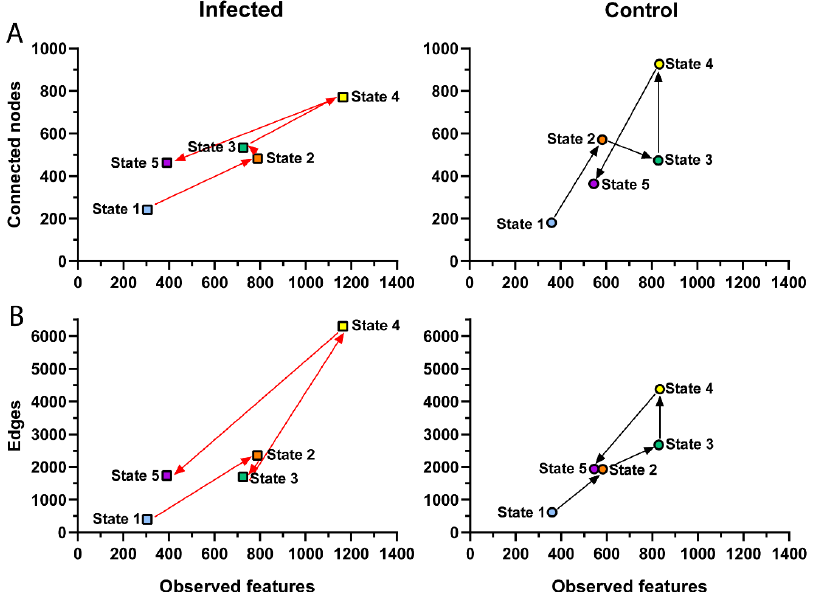
Figure 5. Changes in microbiome structural states of P. homocircumflexum -infected and control groups. Scatter plot showing the mean of observed features versus number of ( A ) connected nodes and ( B ) edges found in the microbial co-occurrence networks of infected (left) and control (right) birds throughout the course of experiment, from state 1 (8 DPI) to 5 (85 DPI) connected by arrows.